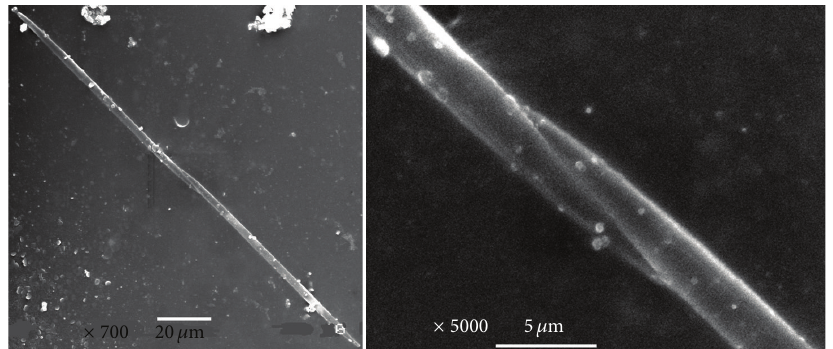
Figure 4: SEM images for Pseudonitzschia pseudodelicatissima . The pointed and tapering ends are highlighted.